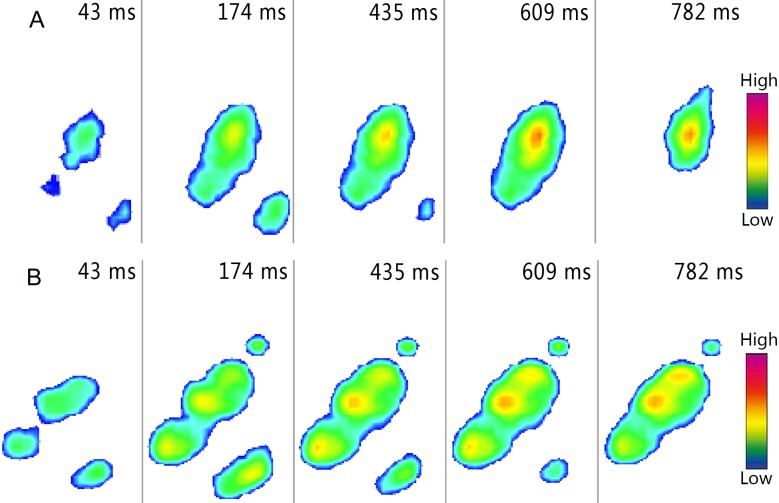
Roll-patterns of right toe during loose sand (A) and solid ground (B) walking trials.The images were recorded at 43, 174, 435, 609 and 782 ms after touch-down of foot.